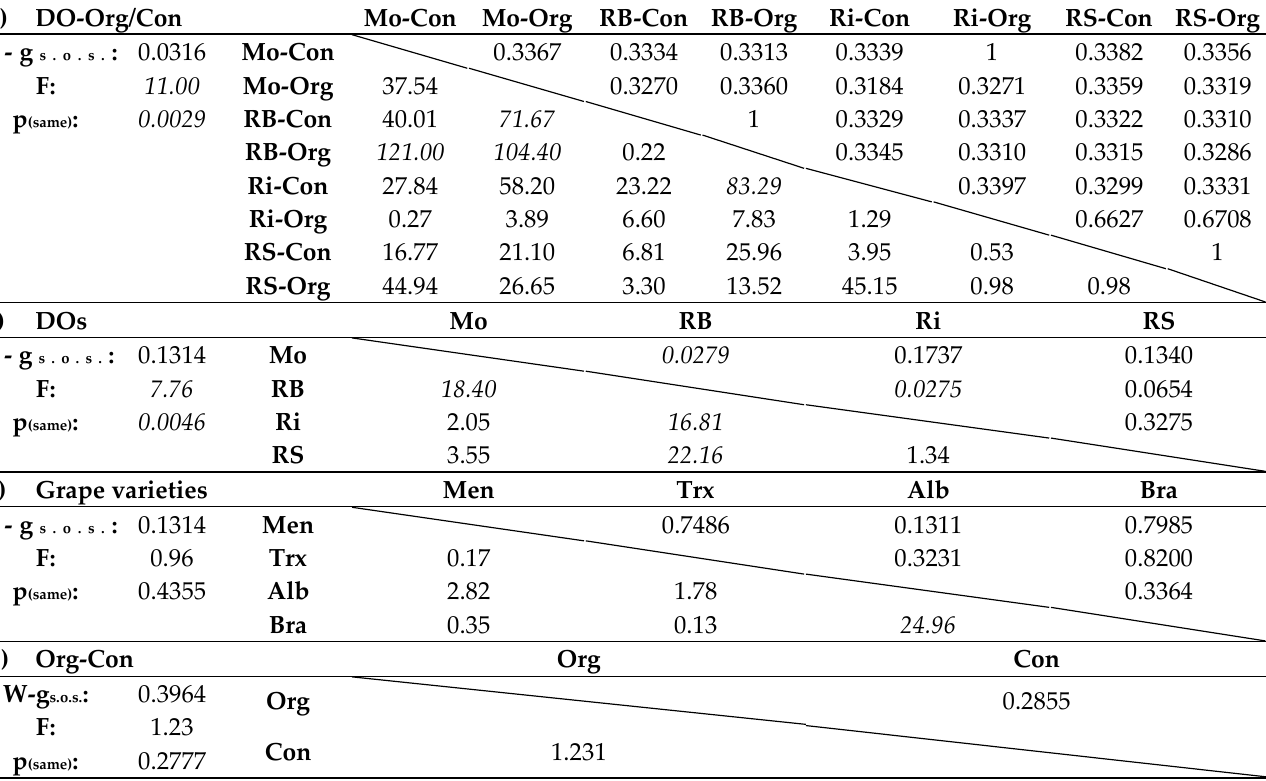
Figure 4. NDVI values and species richness in musts (Sm) and grapes (Sg) per DO (Monterrei, Mo; Rías Baixas, RB; Ribeira Sacra, RS; Ribeiro, Ri), cultivation system (Organic, Org; Conventional, Con), and cultivar (Albariño, Alb; Brancellao, Bra; Mencía, Men; Treixadura, Trx) calculated using Sentinel-2 (S2) and Landsat-8 (L8) imagery close to veraison (04A: 4 August; 25J: 25 July; 15J: 15 July; 29A: 29 August; 12J: 12 July). Table 1. Bray-Curtis PERMANOVA between factors and Sentinel-2 NDVI: (A) Designations of Origin (DOs: Monterrei, Mo; Rías Baixas, RB; Ribeira Sacra, RS; Ribeiro, Ri) – culture system set (Organic, Org; Conventional, Con); (B) DOs; (C) grape varieties (Albariño, Alb; Brancellao, Bra; Mencía, Men; Treixadura, Trx); and (D) cultivation system.